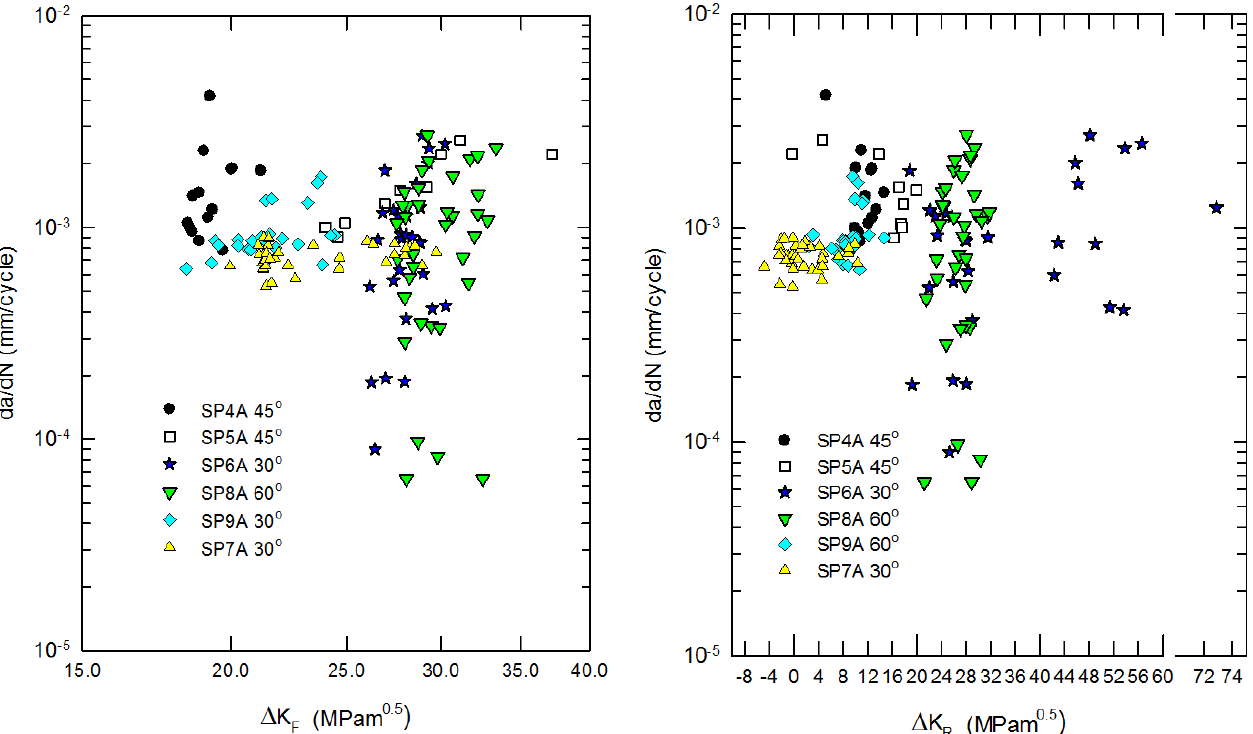
Figure 4: Fatigue crack growth rate data for all inclined crack specimens plotted against K F .